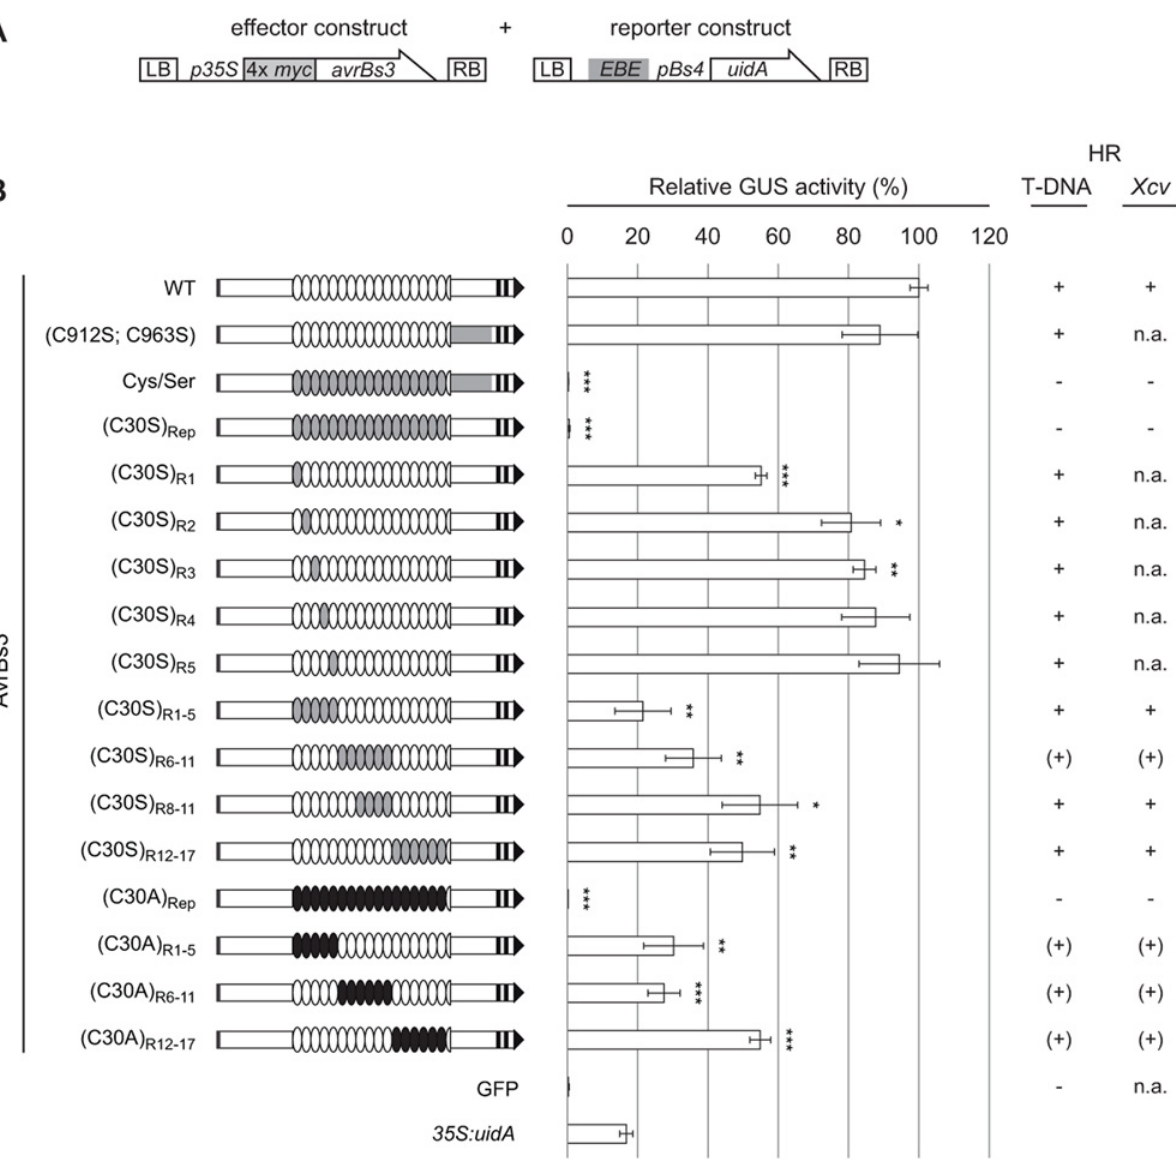
Fig 2. Cysteines in AvrBs3 repeats are required for target gene induction. ( A ) Constructs used for Agrobacterium -mediated T-DNA delivery into leaves of N . benthamiana . The effector construct allows expression of 4× c-Myc-tagged AvrBs3 derivatives under control of the 35S promoter. The reporter construct contains the 19-bp effector binding element (EBE) of AvrBs3 in front of the tomato Bs4 -minimal promoter driving the uidA (GUS) reporter gene [47]. LB, left border; RB, right border. ( B ) GUS activity was determined in N . benthamiana leaves three days after Agrobacterium -mediated co-delivery of the reporter construct with silencing inhibitor p19 and effector constructs encoding AvrBs3 or derivatives. GFP served as negative, 35S : uidA as positive control. Gene-inducing activities of the AvrBs3 derivatives were determined relative to the GUS activity induced by the WT AvrBs3 protein (set to 100%). Grey box, T3S signal; black boxes, NLSs; black arrow, AD. White ovals represent WT repeats, grey and black ovals denote repeats with C30S and C30A substitutions, respectively. The C-terminal region of AvrBs3 containing C912S and C963S substitutions is indicated in grey. Errors bars indicate standard deviations (SD). Asterisks indicate statistically significant differences to GUS activity induced by WT AvrBs3 ( t -test; * , P < 0.05; ** , P < 0.01; *** , P < 0.001). The experiment was repeated once, and four times using the UPA20 box instead of EBE AvrBs3 , with similar results. Columns on the right-hand side summarize the results of the HR induction assays in leaves of resistant pepper (ECW-30R) and Bs3 -transgenic N . benthamiana plants after Agrobacterium -mediated delivery ( “ T-DNA ” ), and in pepper ECW-30R plants after inoculation of Xcv expressing AvrBs3 and a subset of cysteine mutants, respectively. HR development was monitored three to five dpi. +, HR three dpi; (+), delayed/partial HR five dpi;-, no HR five dpi; n.a., not analyzed. The experiments were repeated three times.